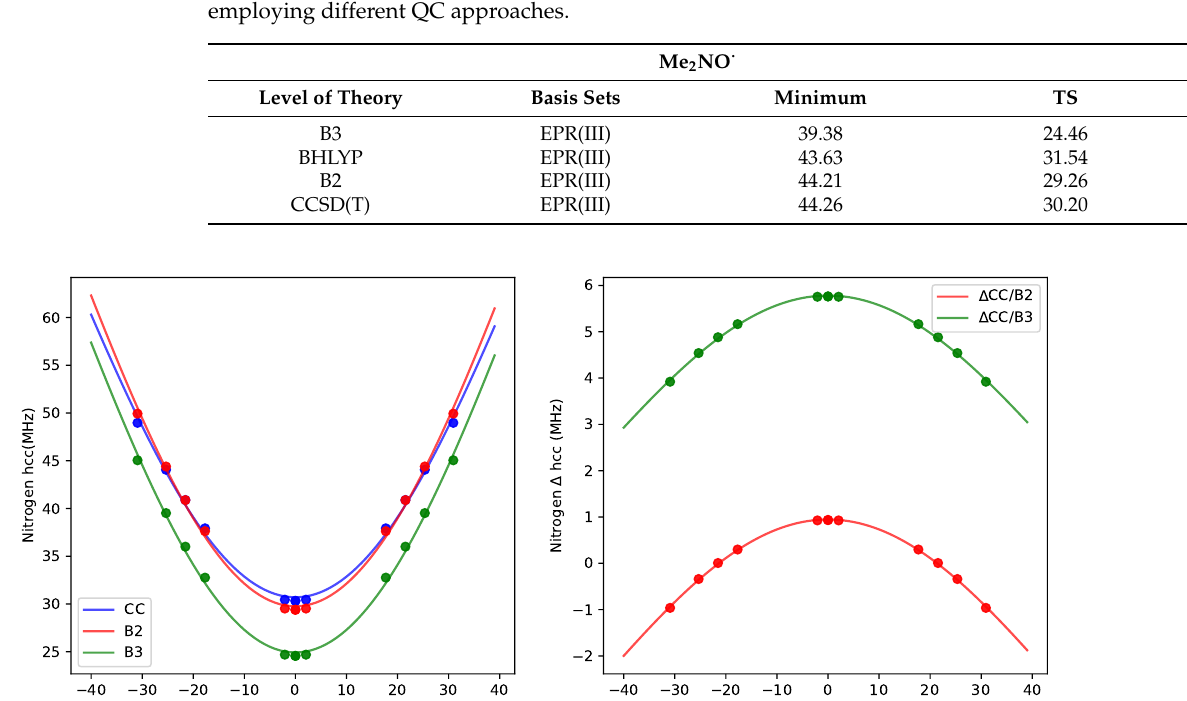
Figure 3. a N profile as a function of the out of plane angle at different levels of theory in conjunction with the EPR(III) basis set. The curves were fitted with ∆ θ = a · cos 2 ( θ ) + b